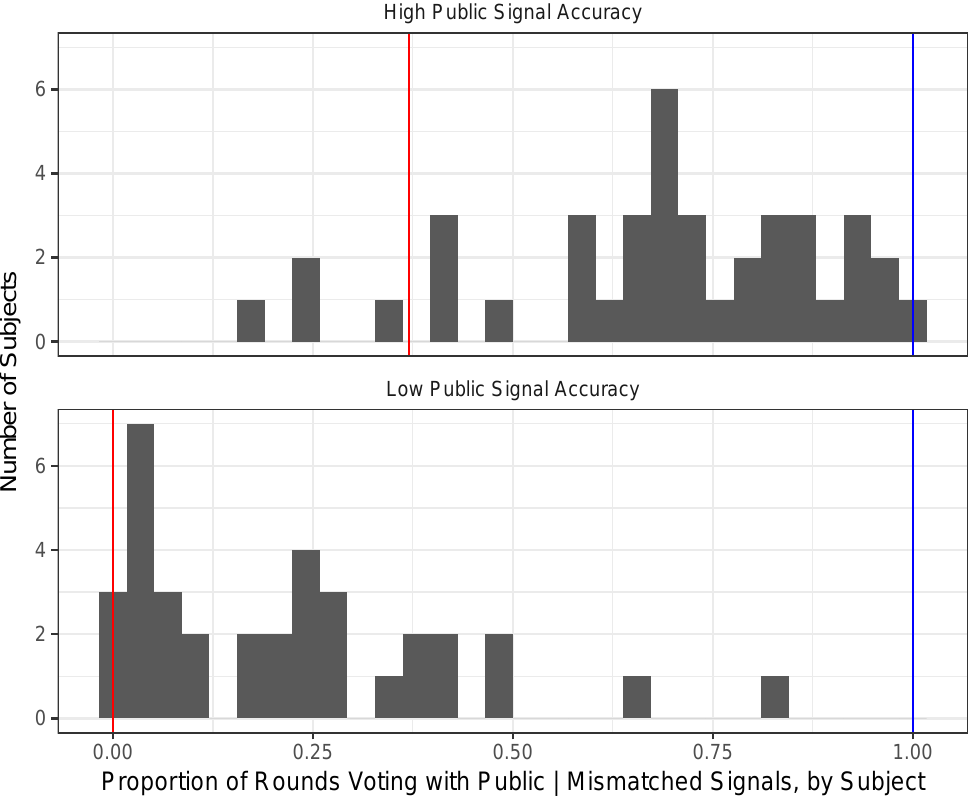
Figure 2. Individual deviations from equilibria under mismatch : Red lines represent the symmetric equilibrium predictions for µ , when the public and private signal disagree. Blue lines represent the conformist equilibrium prediction. When Q > q (upper picture), the number of subjects who vote more with the public signal is greater than when Q < q (lower